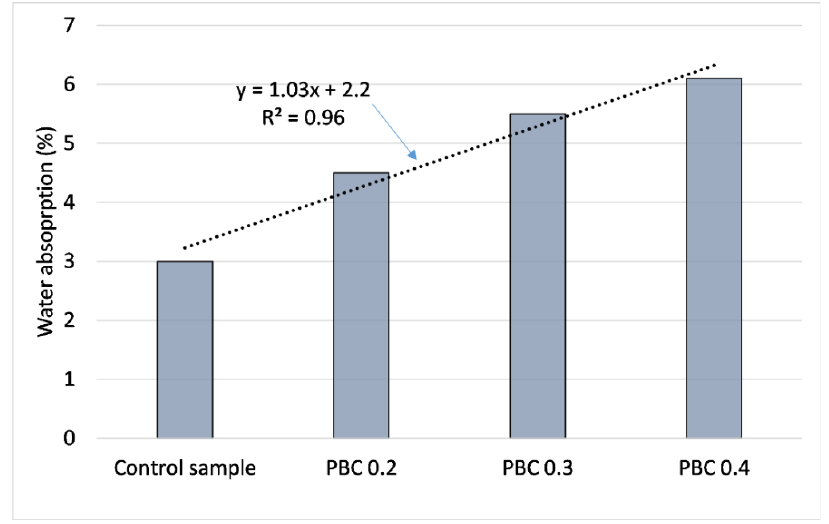
Figure 14. Water absorption for CR IPB at 28 days.